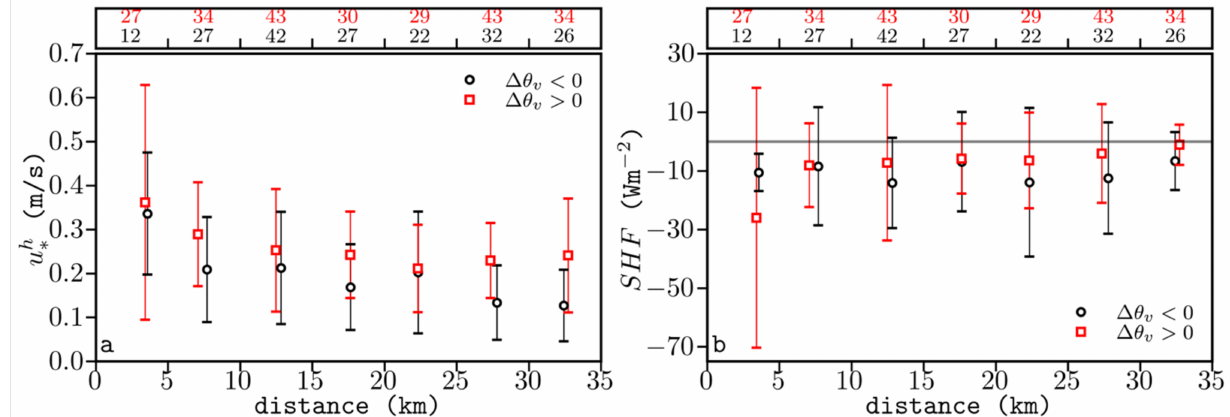
Figure 4. ( a ) Mean and standard deviation of measured u h ∗ (in bins of 5 km) as a function of upwind shore distance, for negative (black circles) and positive (red squares) potential virtual temperature differences between the sea surface and the air, ∆ θ v = θ v ( sea ) – θ v ( air ) . The number of samples (>5) per bin is shown over the plot. ( b ) As in Figure 4a, but for the sensible heat flux ( SHF )